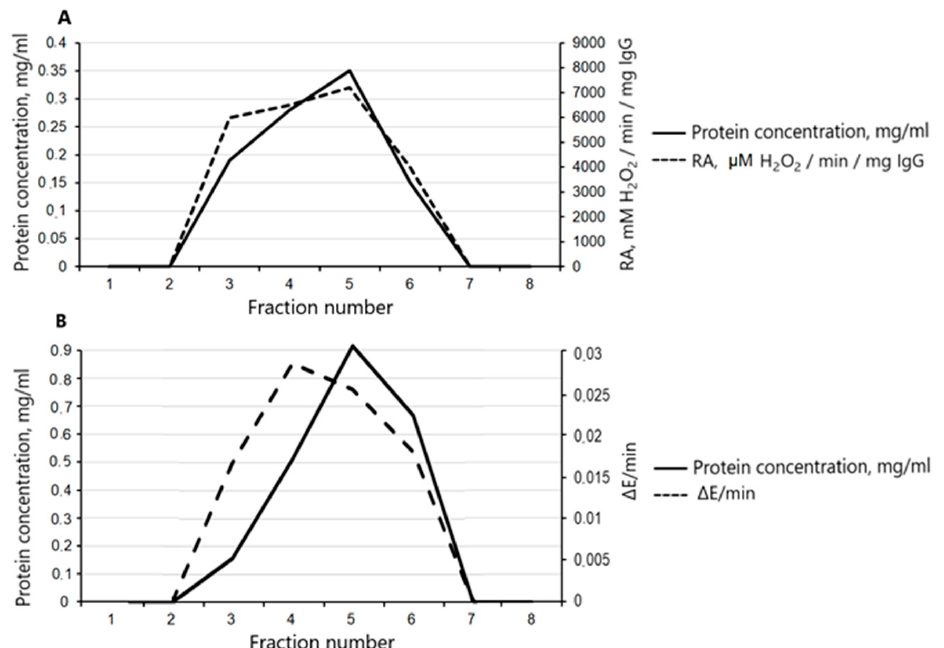
Figure 2. ( A ). The protein elution profile of gel filtration of IgGs under pH shock conditions (solid curve) and the change in relative activity (RA) of the IgG during the degradation of H 2 O 2 in the presence or absence of IgG having catalase activity in the obtained fractions (dashed curve). ( B ). The protein elution profile of gel filtration of IgGs under pH shock conditions (solid curve) and the change in optical density of the solution per minute ( ∆ E/min) in the presence or absence of IgGs having SOD activity in the obtained fractions (dashed curve).